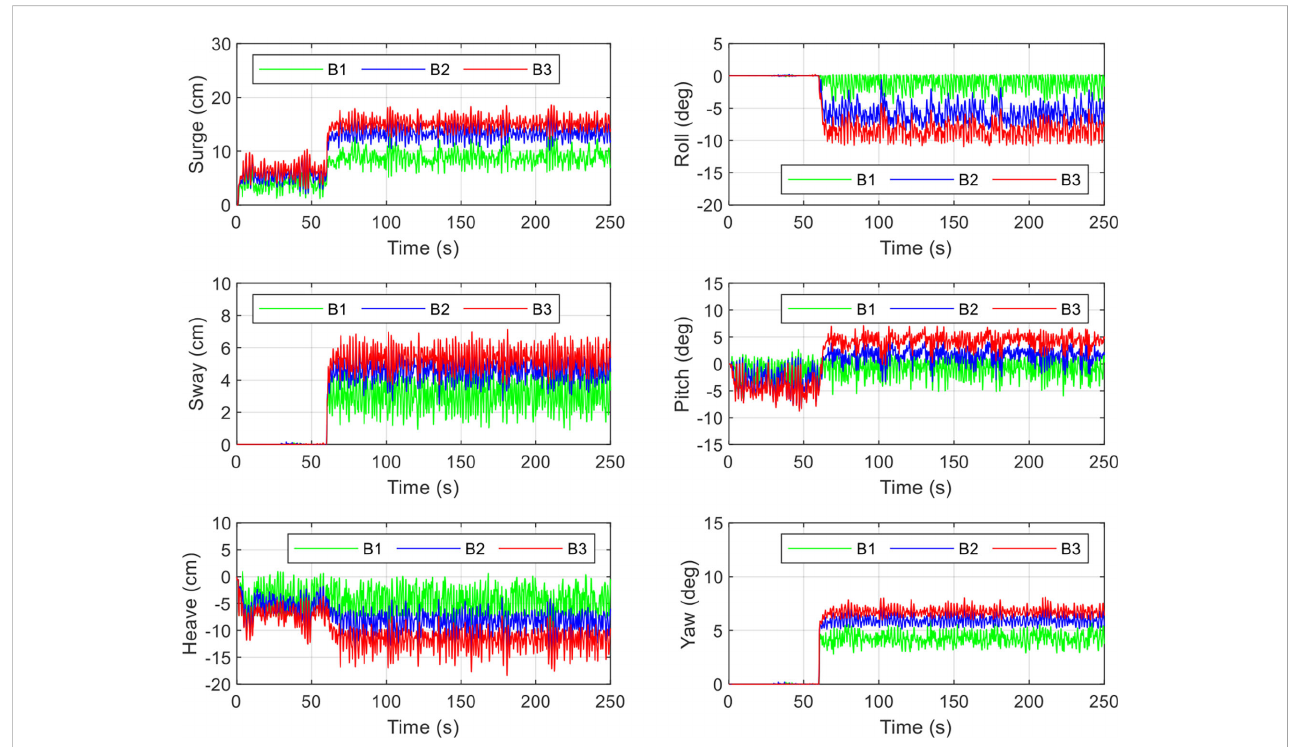
FIGURE 16 In fl uence of the current velocity on the time series 6 DOF motions of the fl oating collar under the mooring line failure of a net cage in irregular waves and currents (numerical simulation).